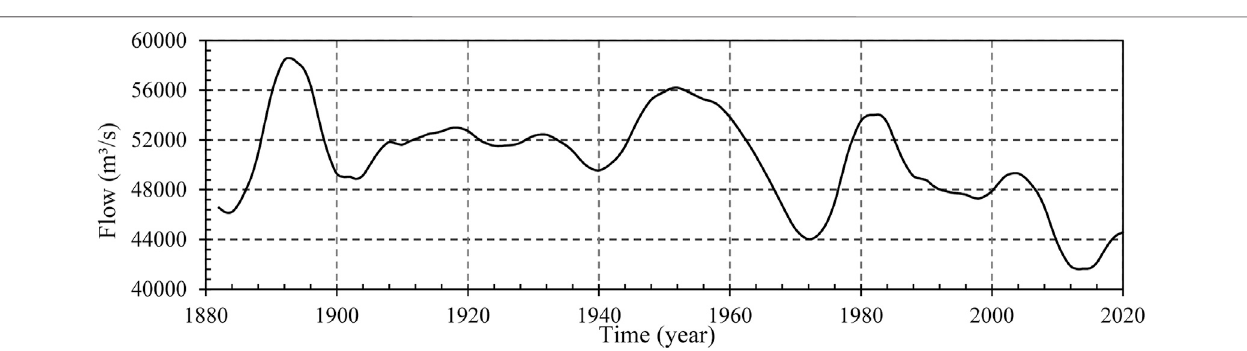
FIGURE 3 | Curve of Morlet wavelet decomposition (A3) of the annual maximum fl ood peak discharge in YC.